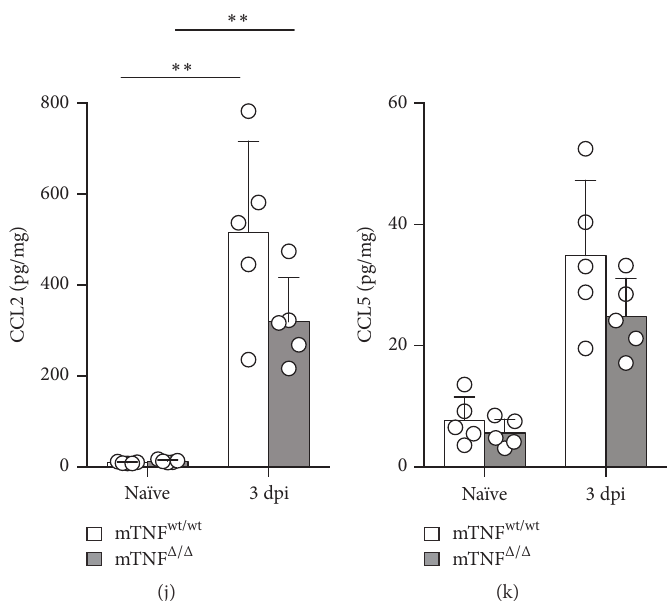
Figure 3: Cytokine and TNFR expression profiling after SCI. (a–k) TNF (a), TNFR1 (b), TNFR2 (c), IL-10 (d), IL-1 𝛽 (e), IL-6 (f), IL-5 (g), IL-2 (h), CXCL1 (i), CCL2 (j), and CCL5 (k) protein levels were quantified by multiplex technology in na¨ıve mice and 3 days after SCI in mTNF wt / wt and mTNF Δ/Δ mice. For each protein, results are expressed as mean ± SD, 𝑛 = 5 mice/group. ∗ 𝑝 < 0.05 and ∗∗ 𝑝 < 0.01 , Mann–Whitney